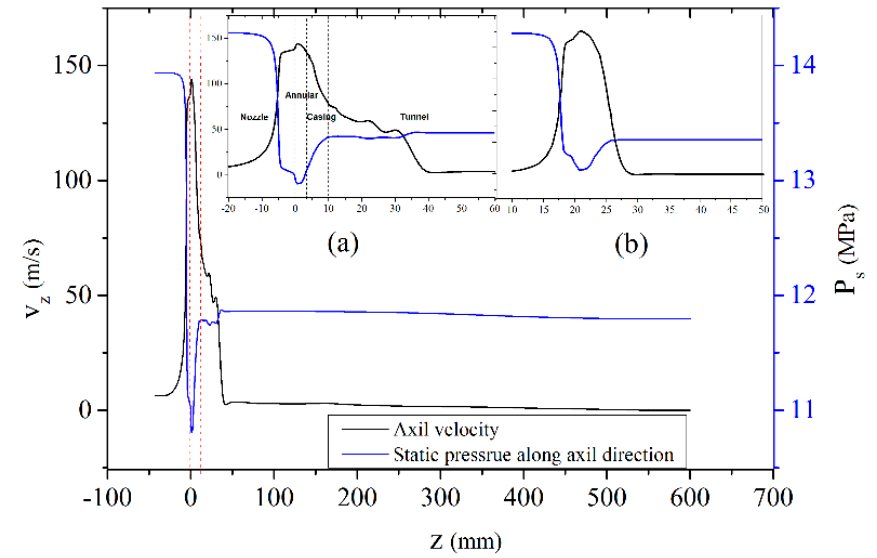
Figure 7. Axial velocity and static pressure along the axis direction.